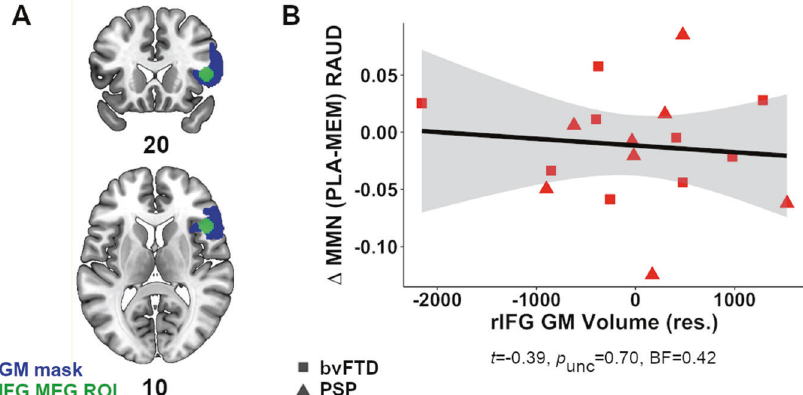
Fig. 5 Association between prefrontal cortical atrophy and changes in MMN response to memantine in auditory cortex. A Anatomical mask (blue areas) representing right inferior frontal gyrus (rIFG) region used for calculating GM volume, as visualised from axial and coronal views. Mask is available at https://neurovault.org/images/776918. Green sphere (7 mm radius) indicates magnetoencephalography (MEG) source region-of-interest (ROI) used in MMN analysis. B Association between residual GM volume (adjusted for age and total intracranial volume) in rIFG and change in MMN to memantine (vs. placebo) (PLA-MEM) across bvFTD (squares) and PSP patients (triangles). bvFTD behavioural variant frontotemporal dementia, PSP progressive supranuclear palsy;, R AUD right auditory cortex, R IFG right inferior frontal need to be considered on basis of interactions between neurotransmitter systems or between connected regions. We propose that the design of future experimental studies may bene fi t from the quanti fi cation of multiple neurotransmitter systems, including neurochemicals changed by disease and those targeted by drugs. Here, GABA concentrations were an anticipated in fl uence (along with glutamate) on individual differences in patient responses to memantine, given that baseline levels moderate GABAergic modulation [8] and are associated with variation in behaviour [26]. Moreover, the effect of other NMDA-R